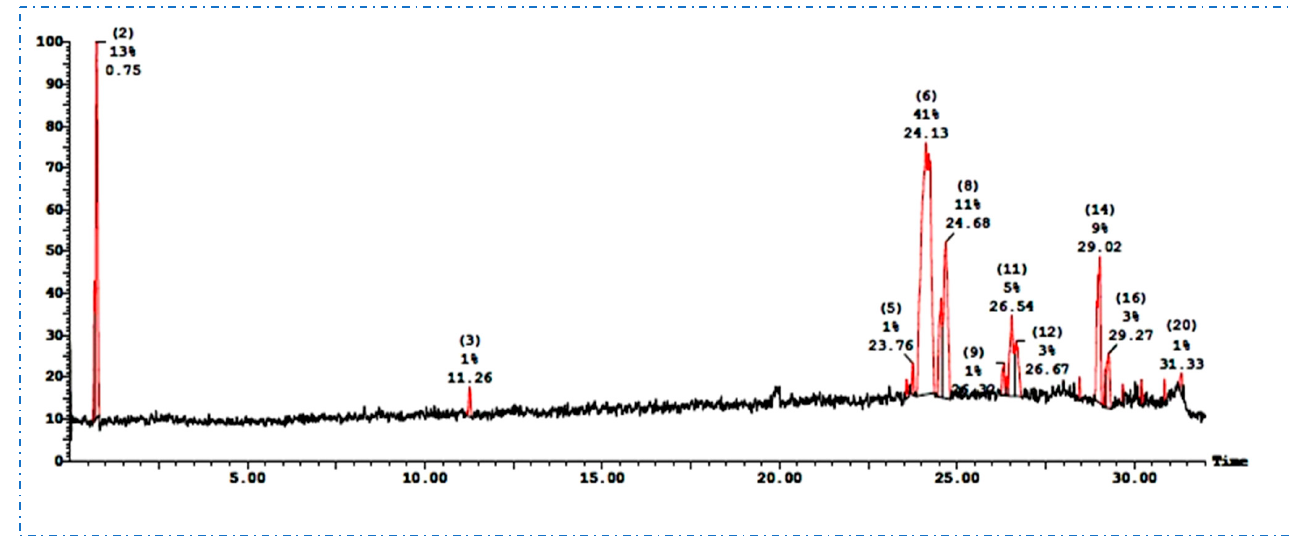
Figure 1. UPLC-ESI-MS/MS chromatogram of the light petroleum fraction of S. hispanica L. aerial parts.